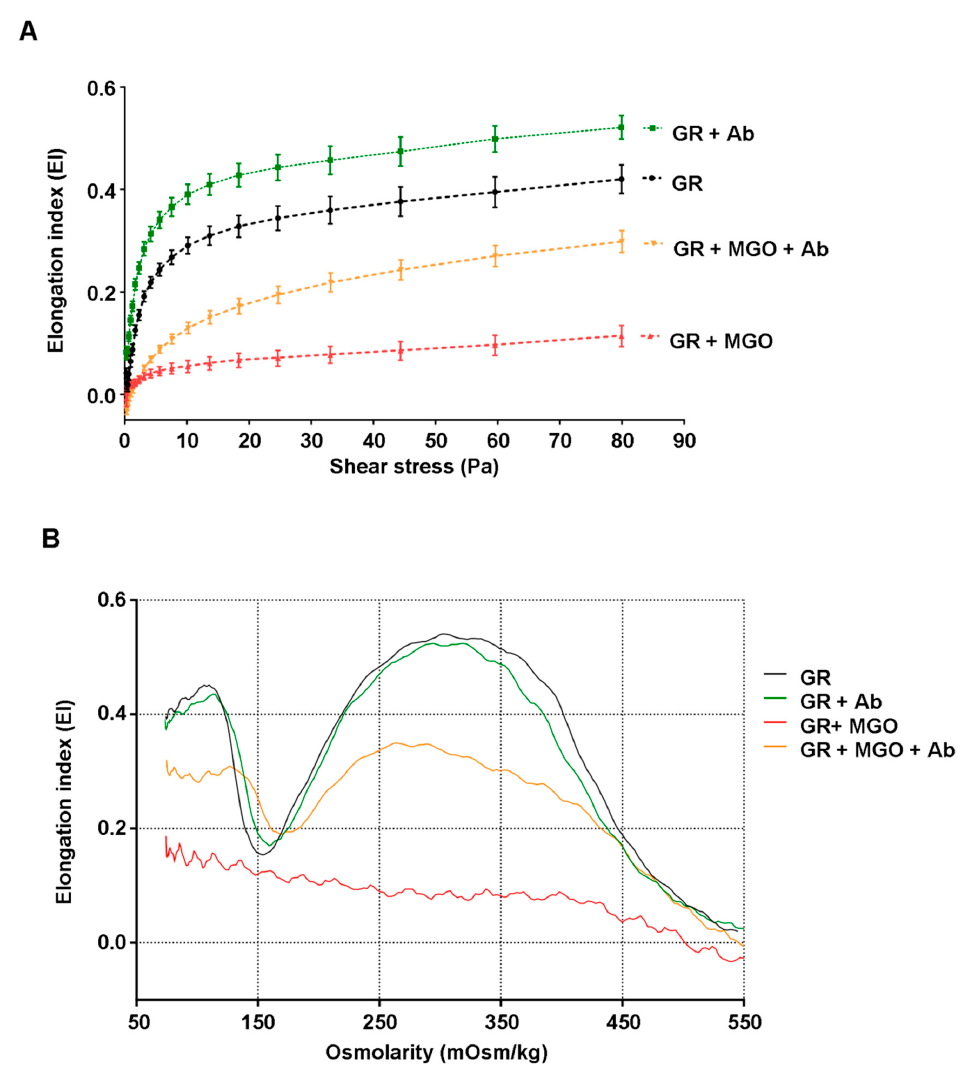
Figure 2. Antirhea borbonica prevents erythrocytes from deformability impairment induced by MGO. ( A ) Curves represent erythrocyte deformation as elongation index as a function of shear stress for RBC (black line); RBC + Ab (green line); RBC + MGO (red line) and RBC + MGO + Ab (orange line) erythrocyte samples. Data are means ± SEM of six independent experiments. ( B ) Representative osmoscan profiles of RBC (black line); RBC + Ab (green line); RBC + MGO (red line) and RBC + MGO + Ab (orange line) erythrocyte samples.